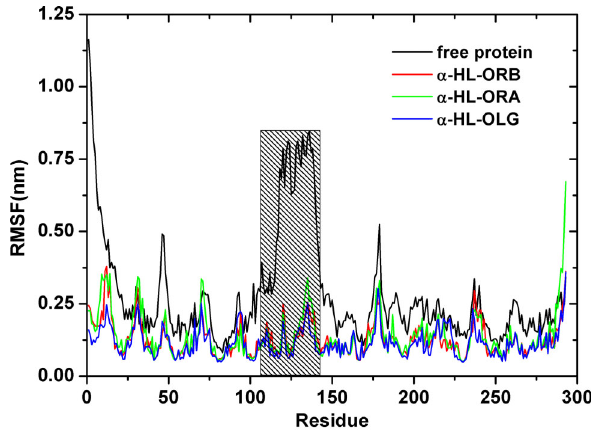
highlighted with gray bars.